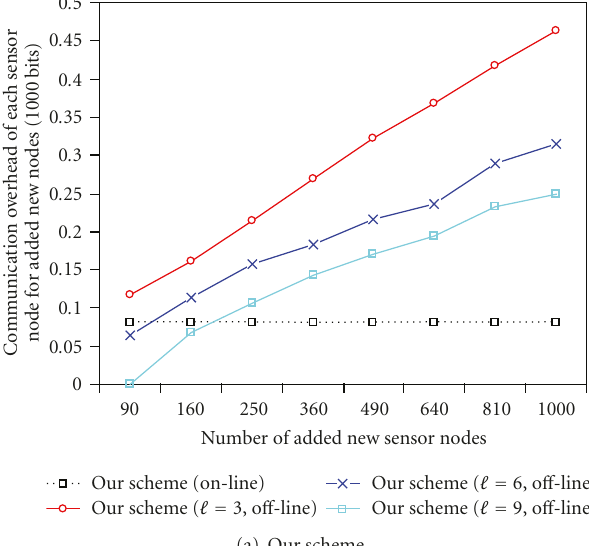
√ √ is regularly organized as m × m number of clusters, and there are exactly 100 sensor nodes in each R × R cluster. The √ 5 R , and the transmission range of each cluster head is set as communications between CHs may be made in a multihop manner if they are separated far away from each other. To simulate the sensor node addition process, we consider 10 new sensor nodes to be added to each cluster. In each message interaction for all protocols, the length of each Id and key takes up 32 and 80 bits, respectively.